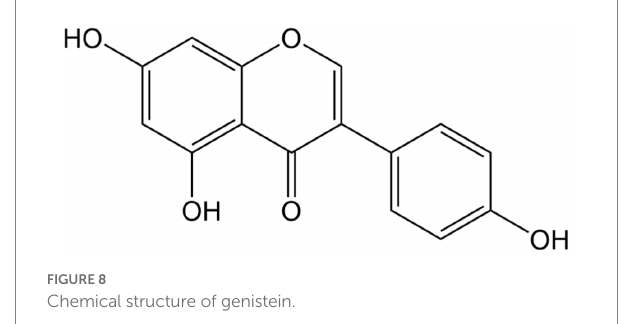
FIGURE 8 Chemical structure of genistein.